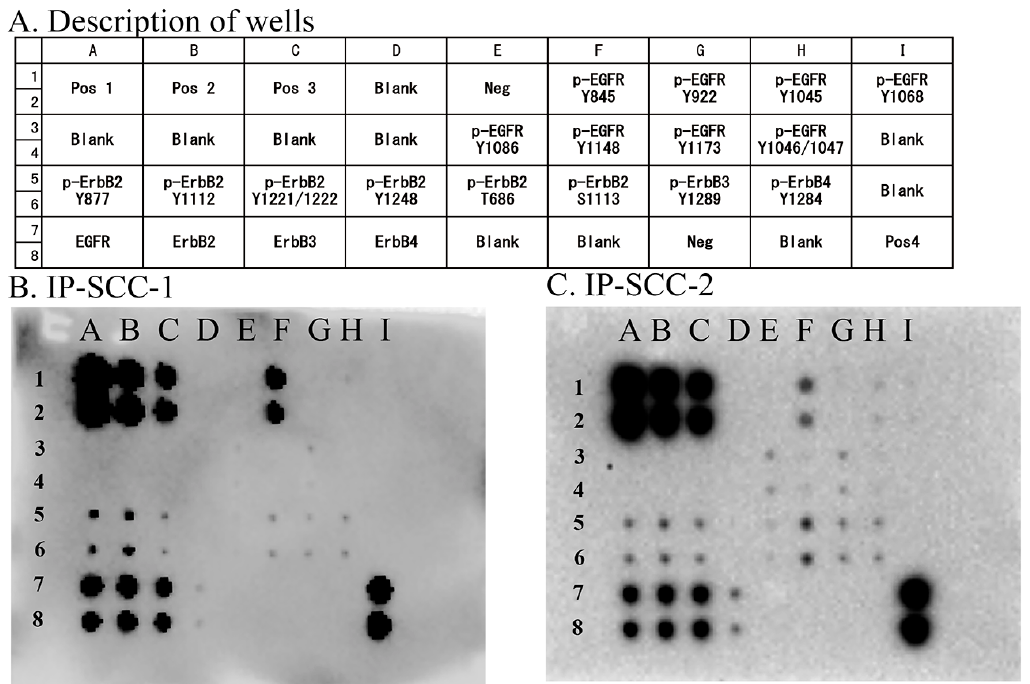
Figure 2. EGFR phosphorylation sites in IP-SCC. Eight phosphorylation sites in EGFR were investi- gated using an EGFR Phosphorylation Antibody Array 1 Assay. ( A ): Description of each well. ( B ): Results for IP-SCC1. ( C ): Results for IP-SCC-2. Of the eight sites, Y845 phosphorylation (F1 and F2 wells) was observed in both cases. Neg, negative control; Pos, positive control. Each antibody is spo tt ed in duplicate vertically.